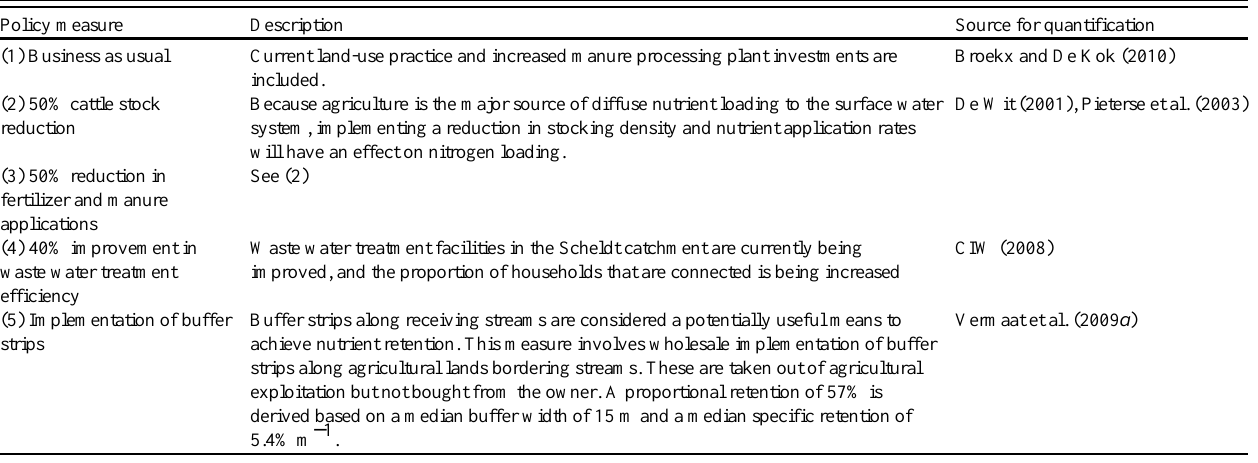
Table 3. Description of different policy measures presently incorporated in the Scheldt model suite.